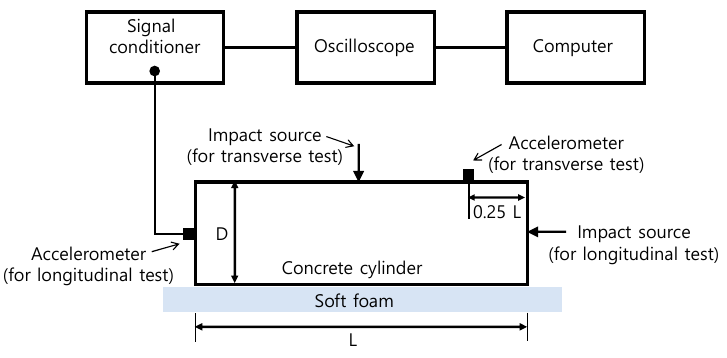
Figure 6. Test setup for resonance frequency tests.